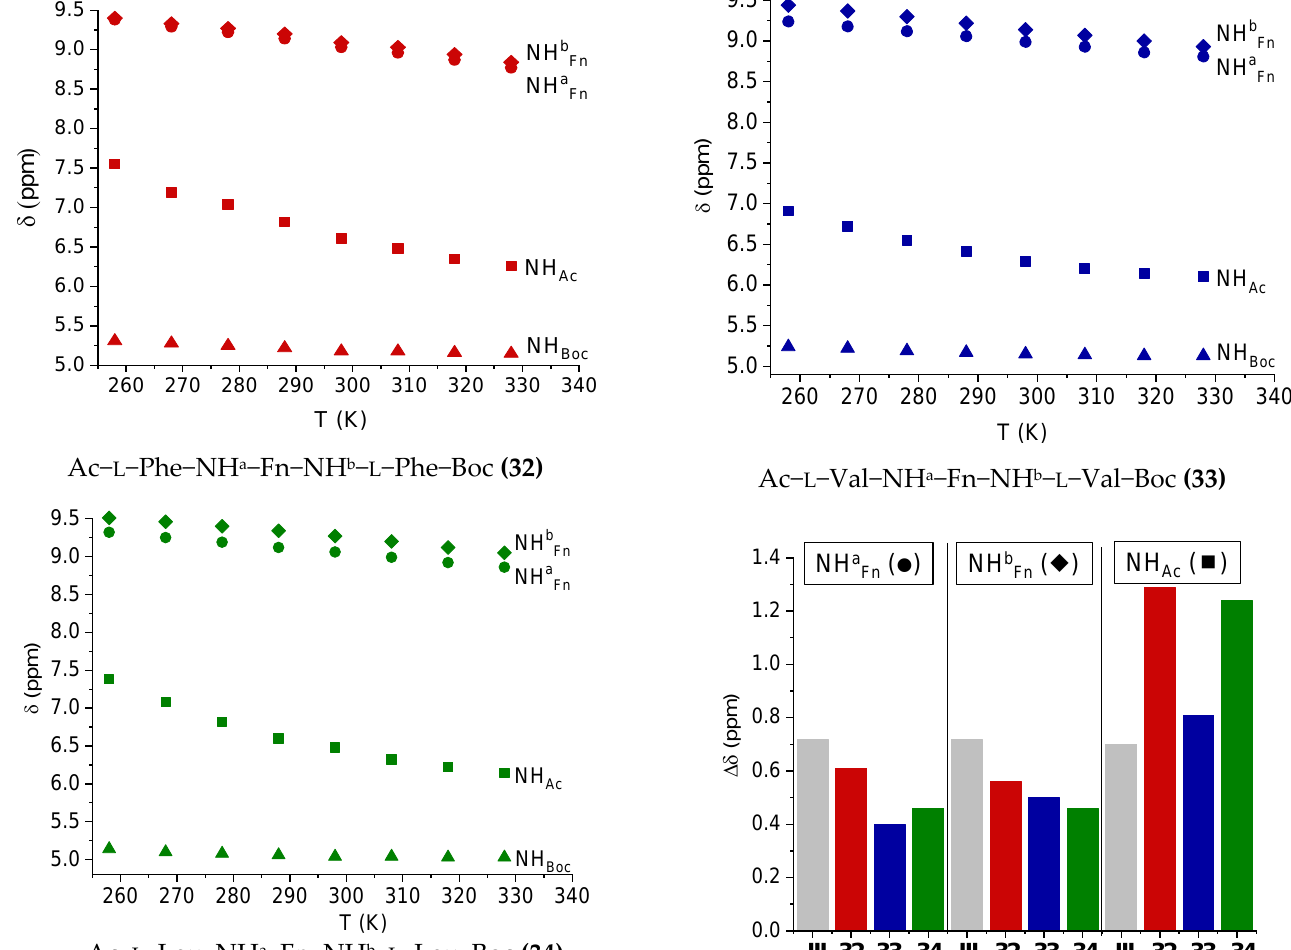
Figure 5. Changes in chemical shifts ( Δδ ) of NH Fn and NH Ac in peptides 32 − 34 in CDCl 3 ( c = 1 × 10 − 3 M) from 258–328